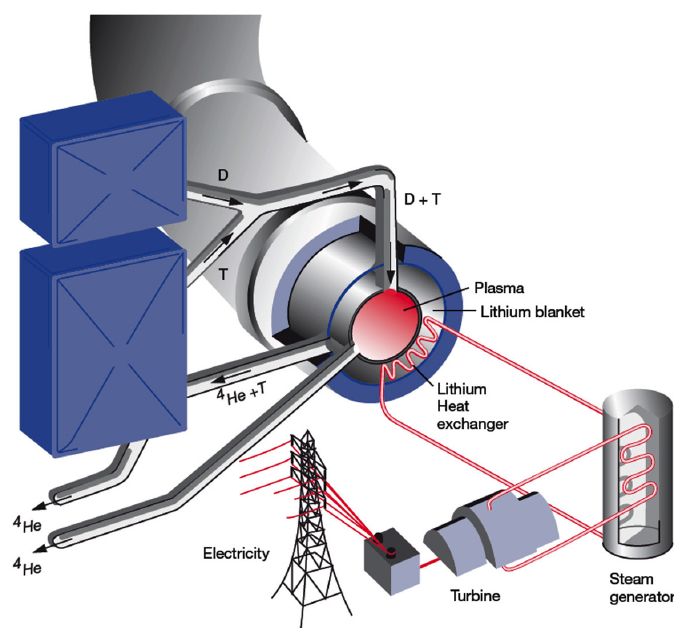
Fig. 11. – Many obstacles still have to be overcome before the first nuclear fusion power plant will be put into operation. Eventually, heat generated in fusion reactions will be used to generate steam to drive a turbine, with electrical power as final